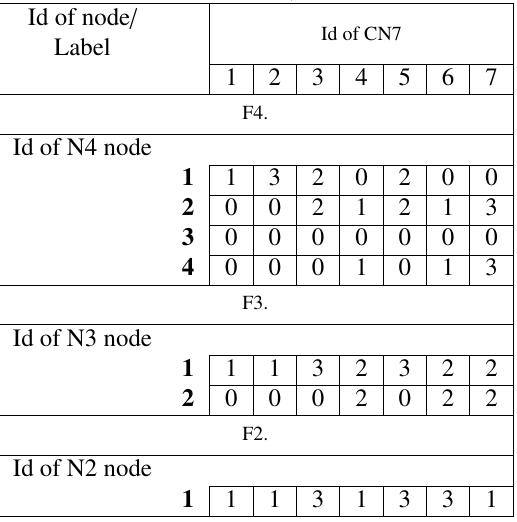
Table 8. Matrix F4, F3 and